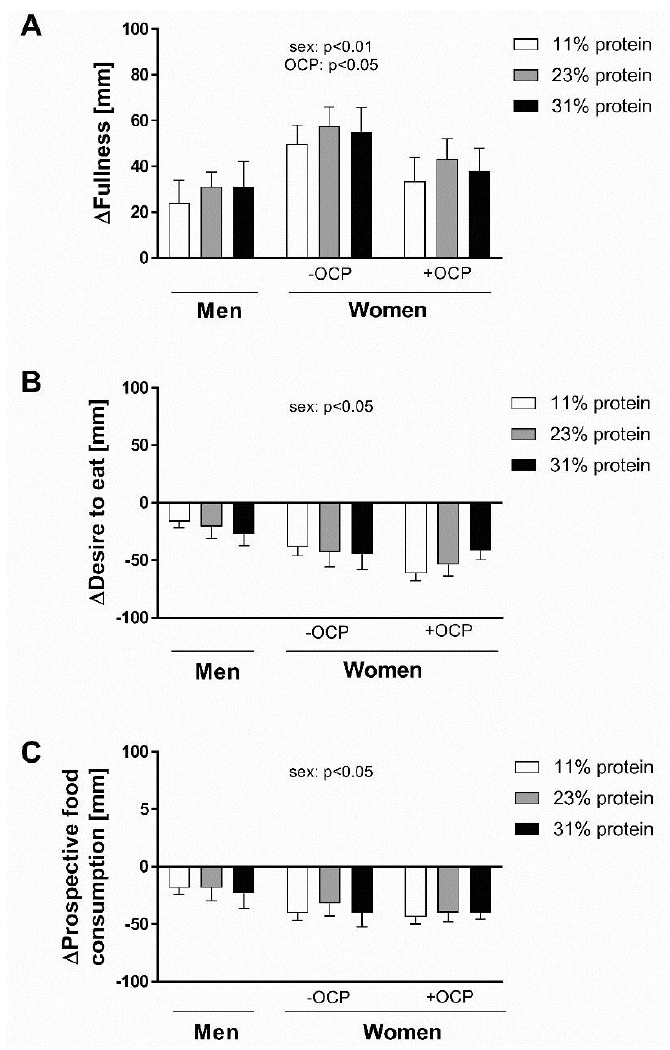
Figure 2. Change in visual analog scale (VAS) ratings of ( A ) fullness, ( B ) desire to eat, and ( C ) how much food the participants thought they could eat (prospective food consumption) after ingestion of an isocaloric meal containing one of three meal protein levels (11, 23, and 31% total energy as protein) relative to baseline (fasted) ratings. Values are mean ± SEM. OCP: oral contraceptive pill; ns: not significant.